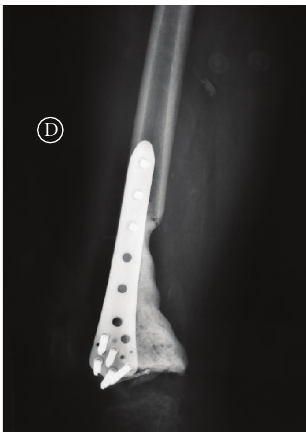
Figure 7: Lateral radiography of the reconstructive technique at the one-year